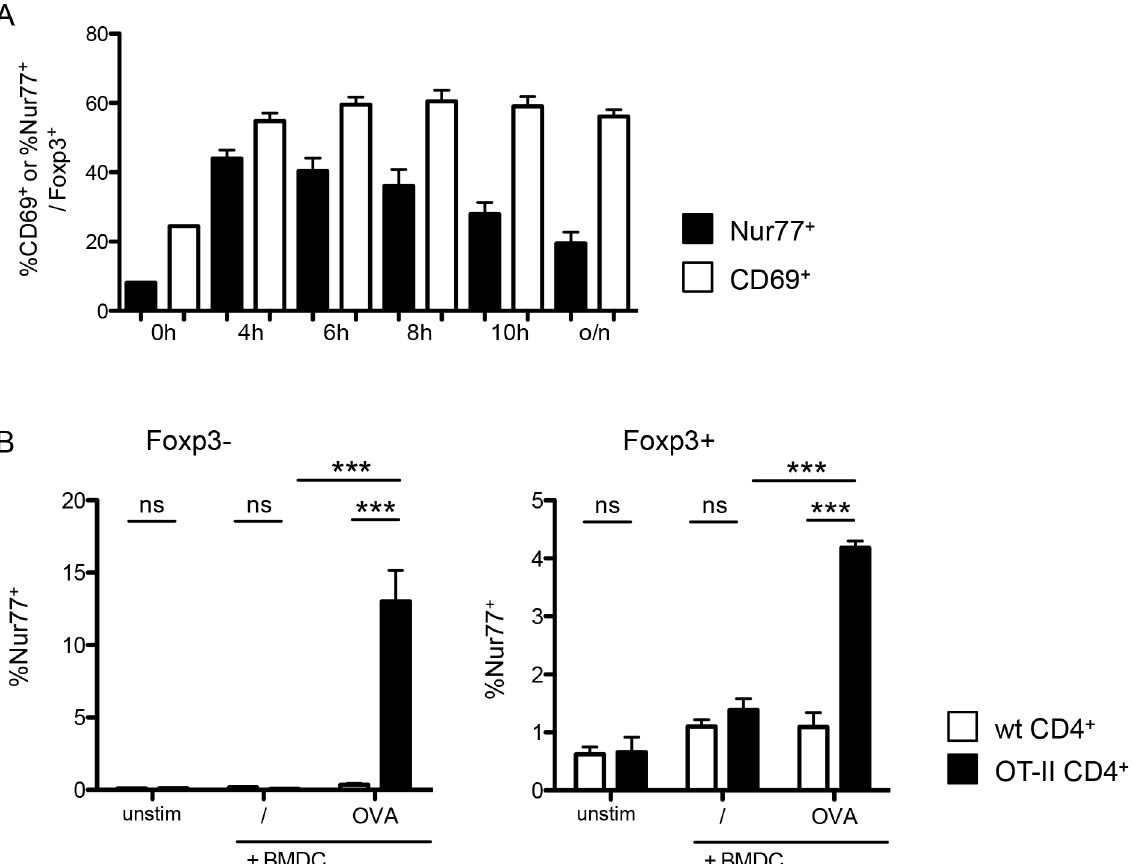
Fig 3. Foxp3 + cells upregulate Nur77 after TCR activation in an antigen-specific manner. (A) Time course of Nur77 (black bars) and CD69 expression (white bars) on Foxp3 + T-cells among sorted CD25 + CD4 + splenocytes stimulated with plate-bound α CD3 and 1U/ml IL-2. Data are representative of 3 independent experiments with n (cid:3) 3. (B) Nur77 expression on Foxp3 - (left) and Foxp3 + (right) among enriched CD4 + T-cells from either wild-type (white bars) or OT-II (black bars) mice, co-cultured overnight with unstimulated, OVA pulsed or α CD3 coated BMDCs. Data are representative of two independent experiments, with each n = 3 per group. unstim, control without BMDC; /, unpulsed BMDC; OVA, OVA-pulsed BMDC, anti-CD3, anti-CD3-coated BMDC. Data show mean + SD, * p (cid:1) 0.05, *** p (cid:1) 0.001; ns, non significant. Data are representative of four independent experiments each with n = 3 per group.